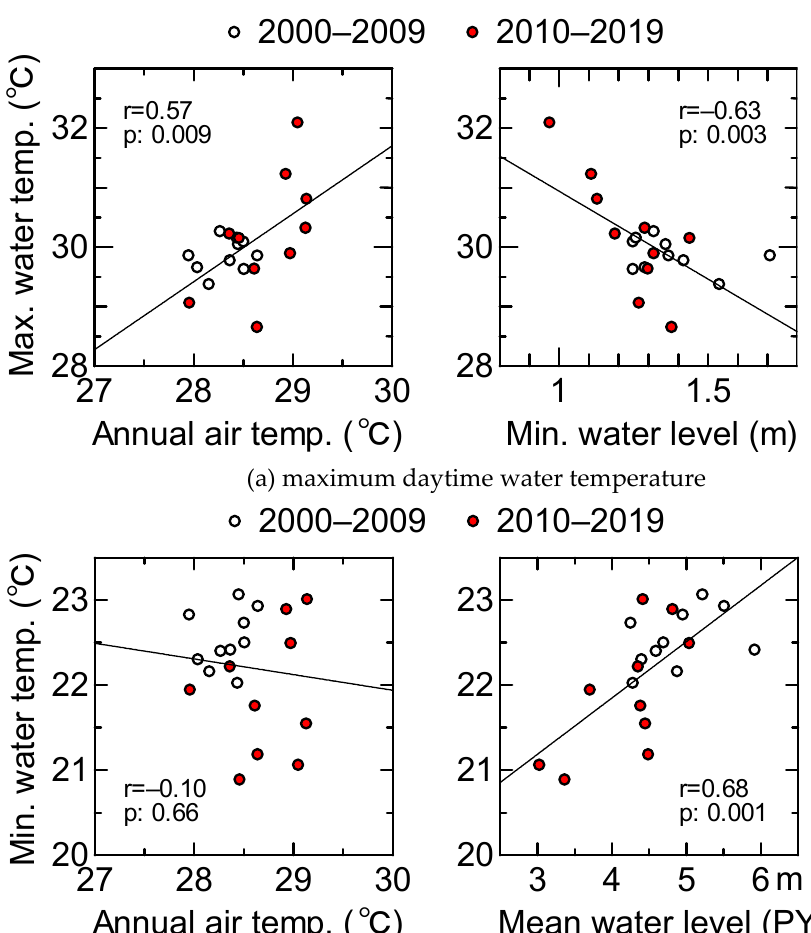
Figure 7. Scatter plots of the maximum and minimum temperatures in the Tonle Sap Lake.